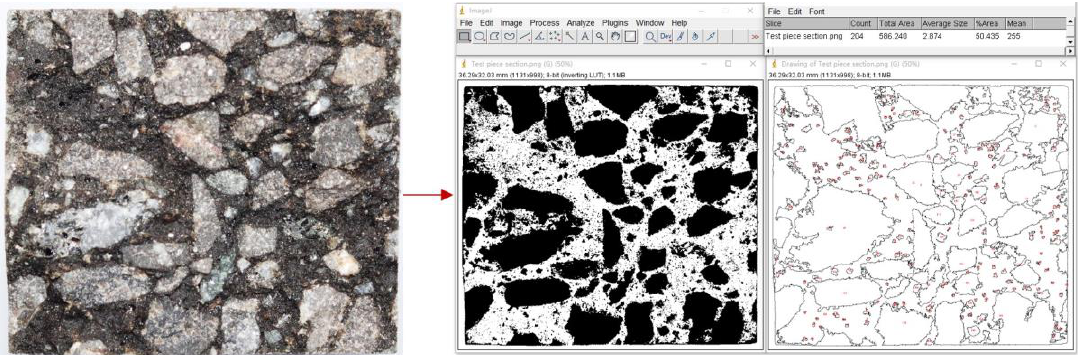
Figure 6. Beam fracture section digital image information acquisition.